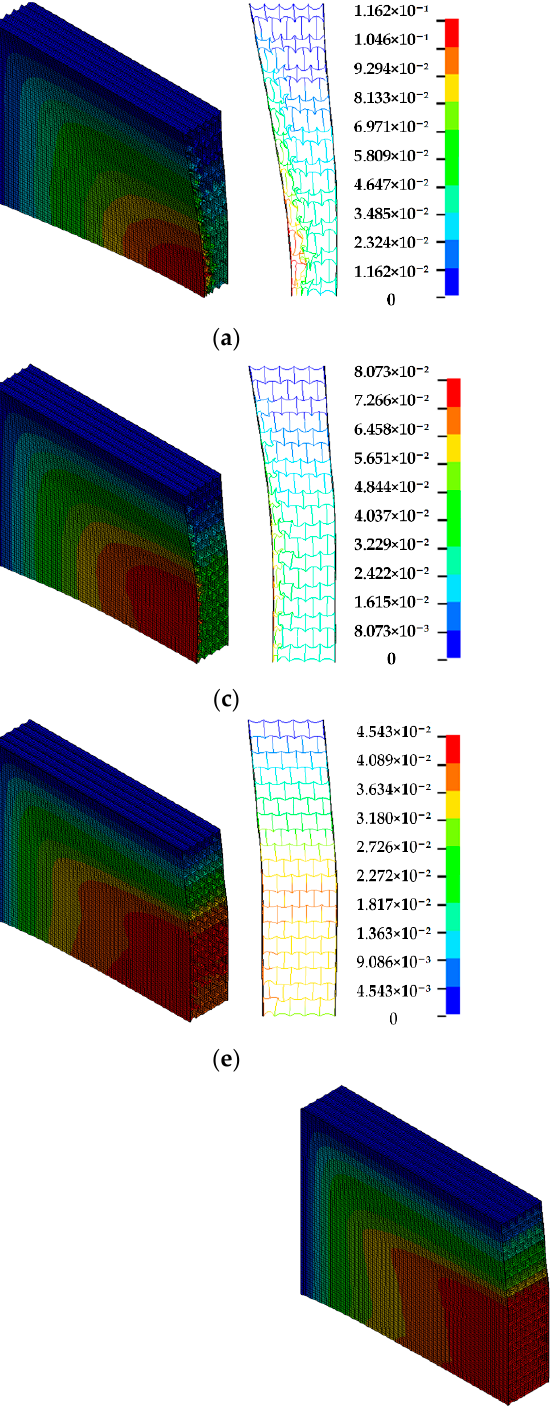
Figure 14. Concave arc honeycomb with different concave angles.